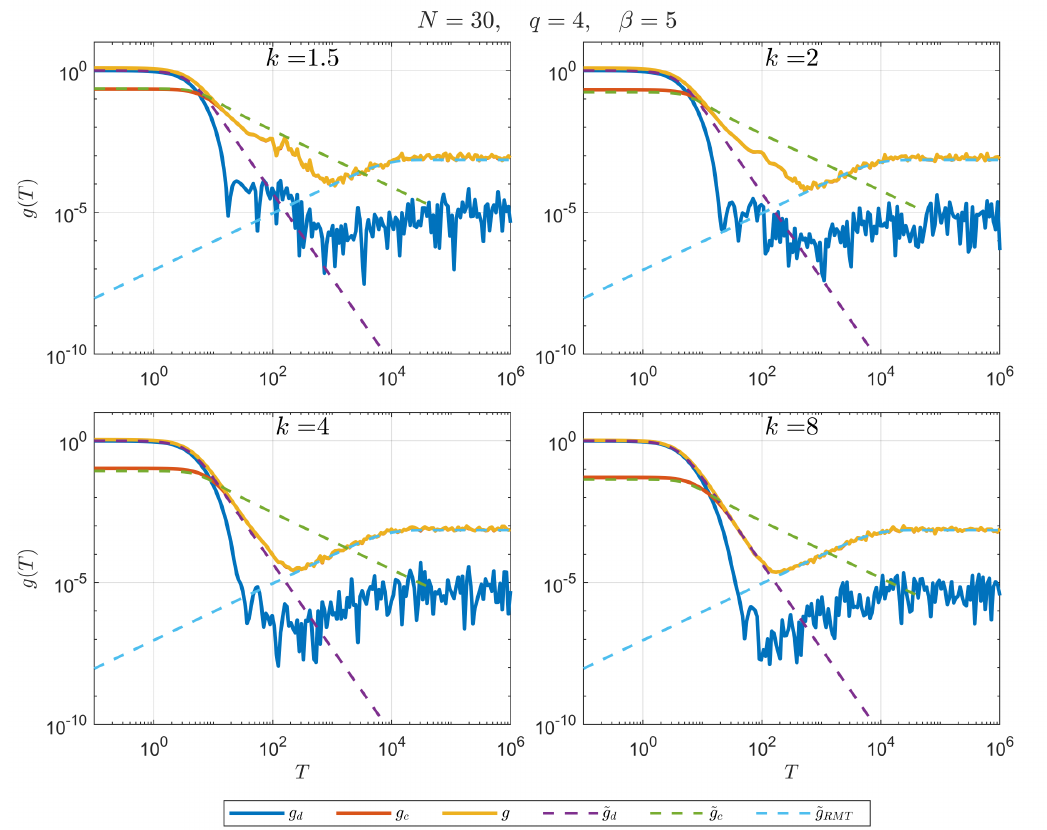
Figure 5 . Full spectral form factor g , connected part g c , and disconnected part g d , obtained by exact diagonalization of the sparse SYK Hamiltonian define over a regular hypergraph, and averaged over 100 disorder realizations of the random couplings. These are compared to the analytical Q - Gaussian approximation ˜ g , ˜ g , and ˜ g c d RMT